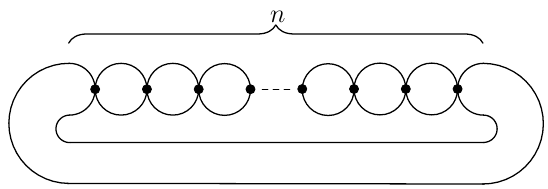
Figure 3 . Chain of bubbles with n ≥ 1 vertices. The two-point kernel B corresponds to one of the bubbles in the